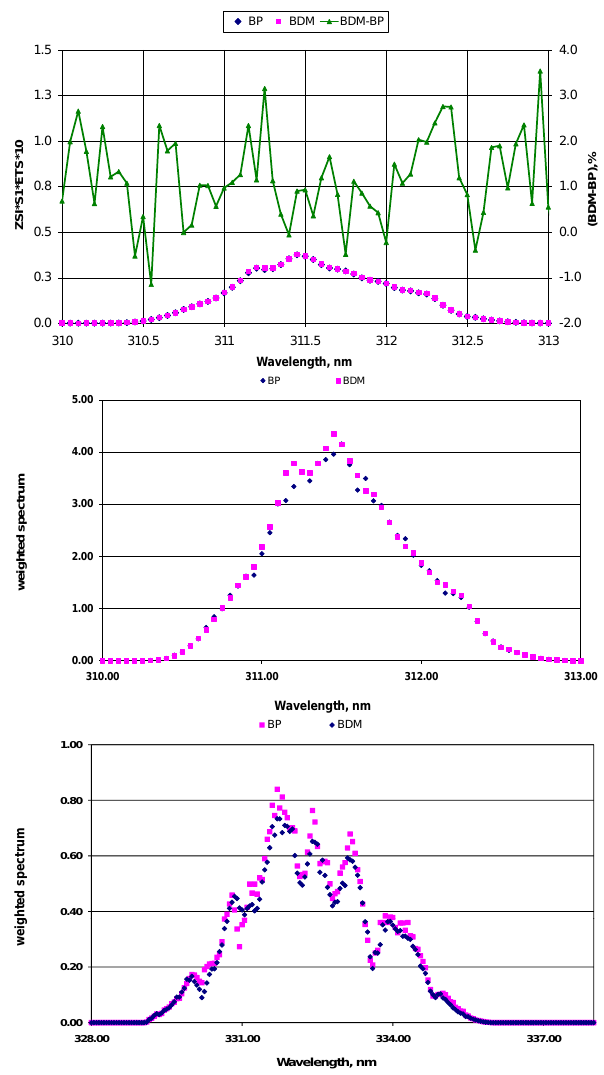
Fig. 3. (a) Shows simulated zenith-sky intensity after applying the Dobson bandpass function. Results are shown for simulations of the solar radiation scattered at 85 degrees SZA and absorbed by 325DU ozone column with a vertical distribution taken from the middle lati- tude climatological profile. Two sets of calculations are done based on the BP (blue) and BDM (purple) ozone cross-section datasets. The spectrally-resolved percent difference between the two simu- lations is shown as the green line (right side scale) over the spec- tral range of the short Dobson slit. (b) Temperature dependence of BP (blue) and BDM (purple) cross-sections at shorter Dobson wavelengths is shown for linear term of temperature polynomial fit weighted by Dobson band-pass. (c) The same as (b) , but for longer